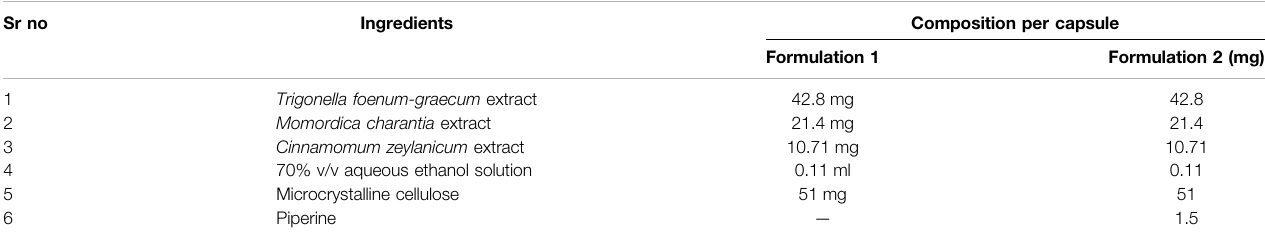
TABLE 1 | Composition of the herbal formulations developed in laboratory. Sr